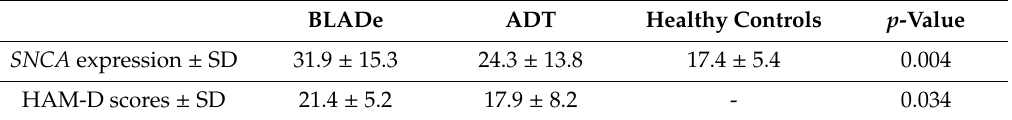
Table 2. Values for SNCA mRNA expression and psychometric scores. SNCA mRNA expression and Hamilton depression rating scale (HAM-D) scores di ff er significantly between groups (ANOVA). HAM-D was not conducted in the control